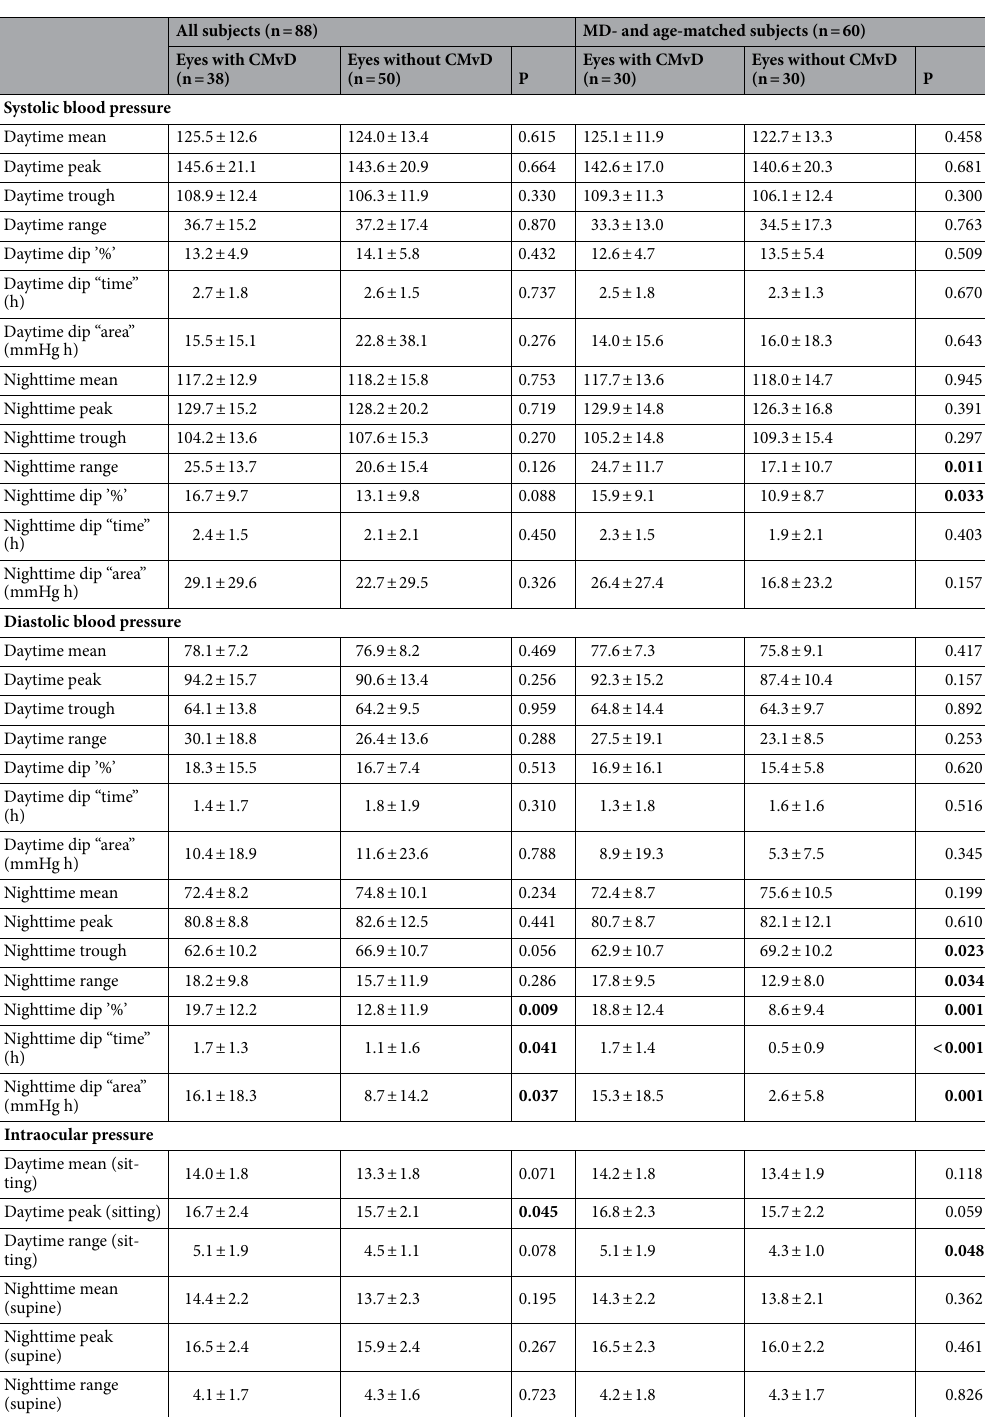
Table 2. Comparison of in-hospital 24-h blood pressure and intraocular pressure between eyes with and without choroidal microvasculature dropout (CMvD) in eyes with normal-tension glaucoma. Statistically significant differences are shown in bold. MD mean